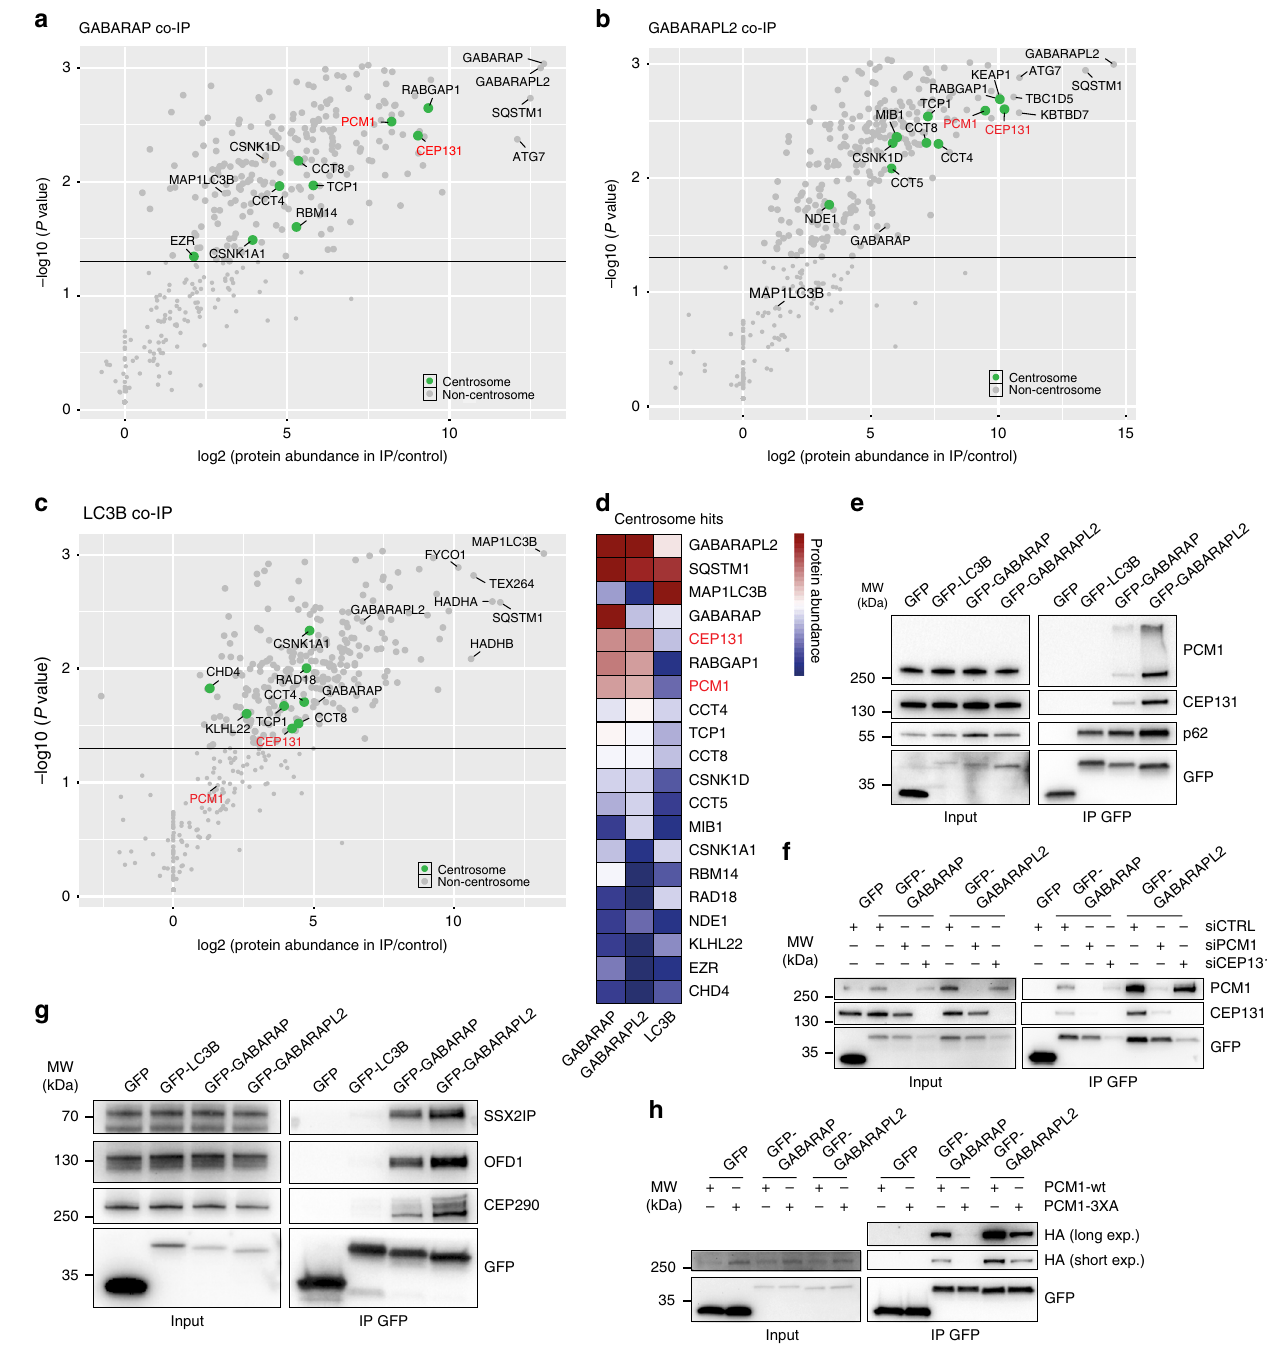
Fig. 4 Centriolar satellite components interact with GABARAPs but not LC3B. a – c Scatter plots showing enrichment values ( x -axis) and corresponding signi fi cance levels ( y -axis) for proteins co-purifying with GFP-tagged GABARAP, GABARAPL2 or LC3B, n = 4. Centrosomal proteins are indicated in green, horizontal line indicates signi fi cance with threshold P -value < 0.05. d Heat map representing abundance of centrosomal proteins across co-IPs from A-C with p < 0.05 for at least one bait. Data are bait normalized to correct for differences in expression levels of bait proteins. e GFP-precipitation of lysates from inducible GFP-3xFLAG or GFP-tagged LC3B, GABARAP or GABARAPL2 MCF7 cells analyzed for co-precipitation of endogenous CEP131 and PCM1, n = 3. f GFP precipitation of GFP-3xFLAG, GFP-GABARAP or GFP-GABARAPL2 in U2OS cells treated with control, PCM1 or CEP131 siRNAs and blotted for co-precipitation of endogenous PCM1 and CEP131, n = 3. g GFP-precipitation of HEK293 lysates following co-transfection of GFP-3xFLAG or GFP- tagged GABARAP or GABARAPL2 with HA-PCM1-wt or HA-PCM1-3XA analyzed for co-precipitation of HA-tagged PCM1 variants, n = 3. h GFP- precipitation of GFP-3xFLAG or GFP-tagged LC3B, GABARAP or GABARAPL2 in HEK293 cells analyzed for co-precipitation of endogenous SSX2IP, OFD1 and CEP290, n =